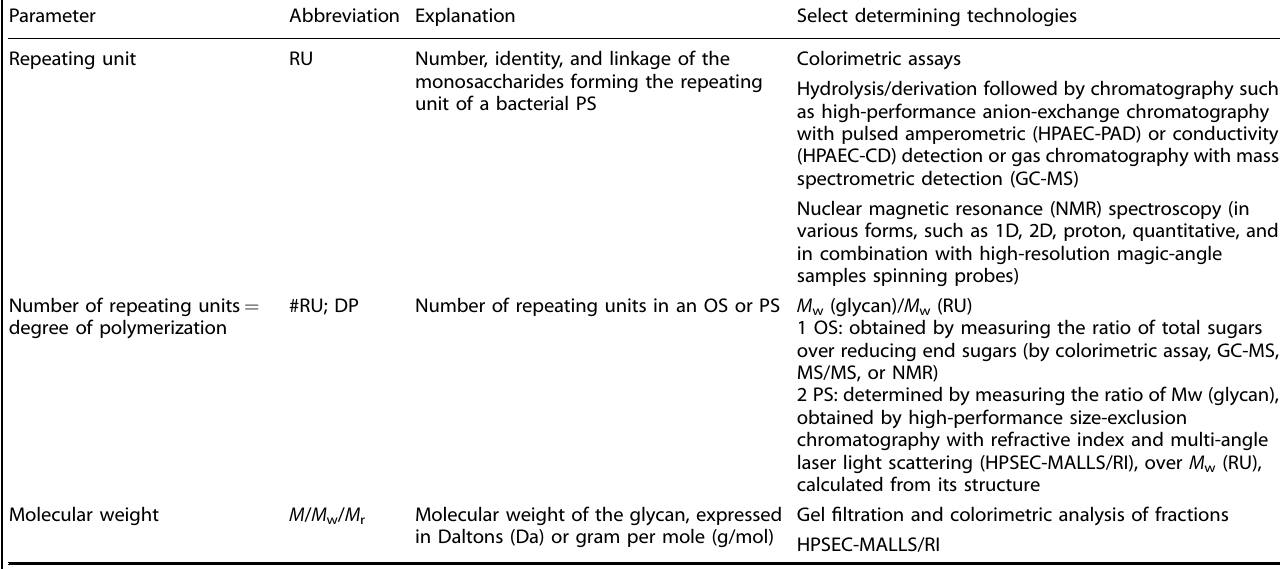
Table 1. Different parameters that characterize the glycan chain length of glycoconjugate vaccines.